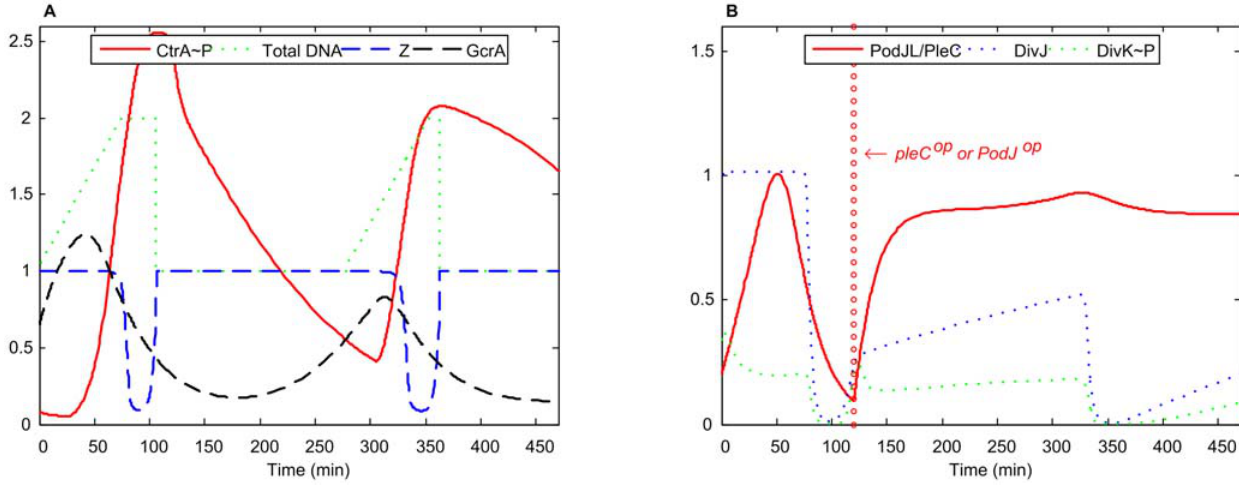
Figure 12. Simulation of pleC op /podJ op mutant. k s,PodJL =0, k 9 =0.043 (100% of WT).